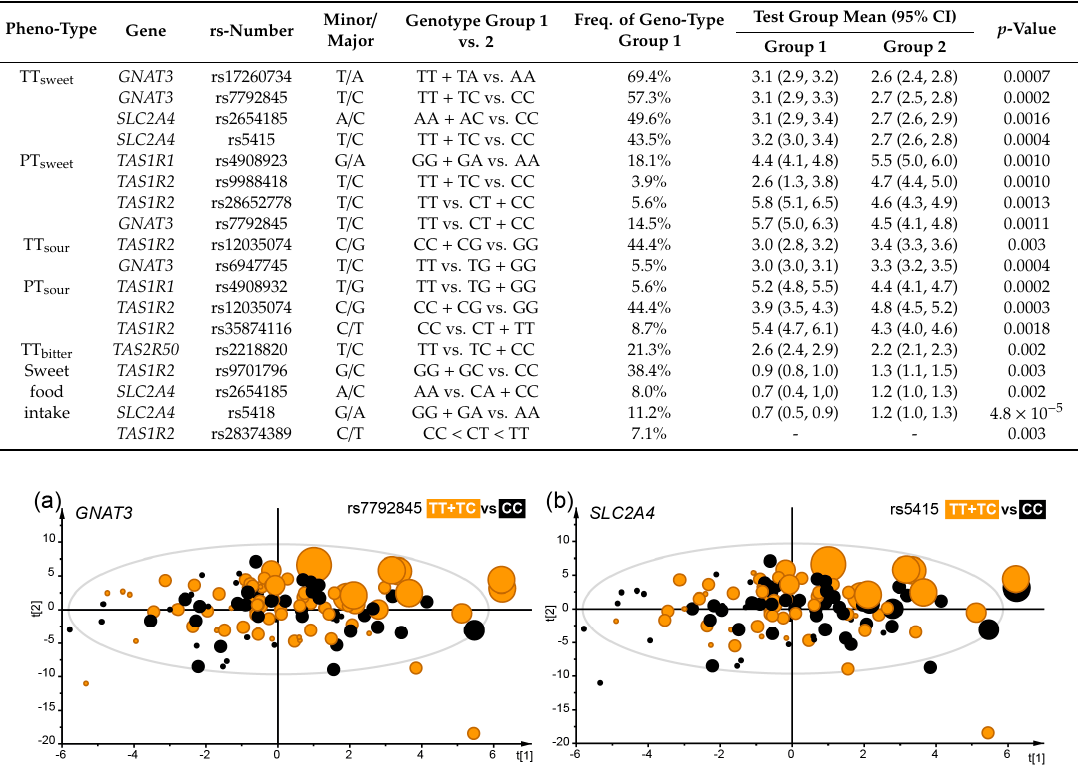
for the phenotypes are given for each genotype group.